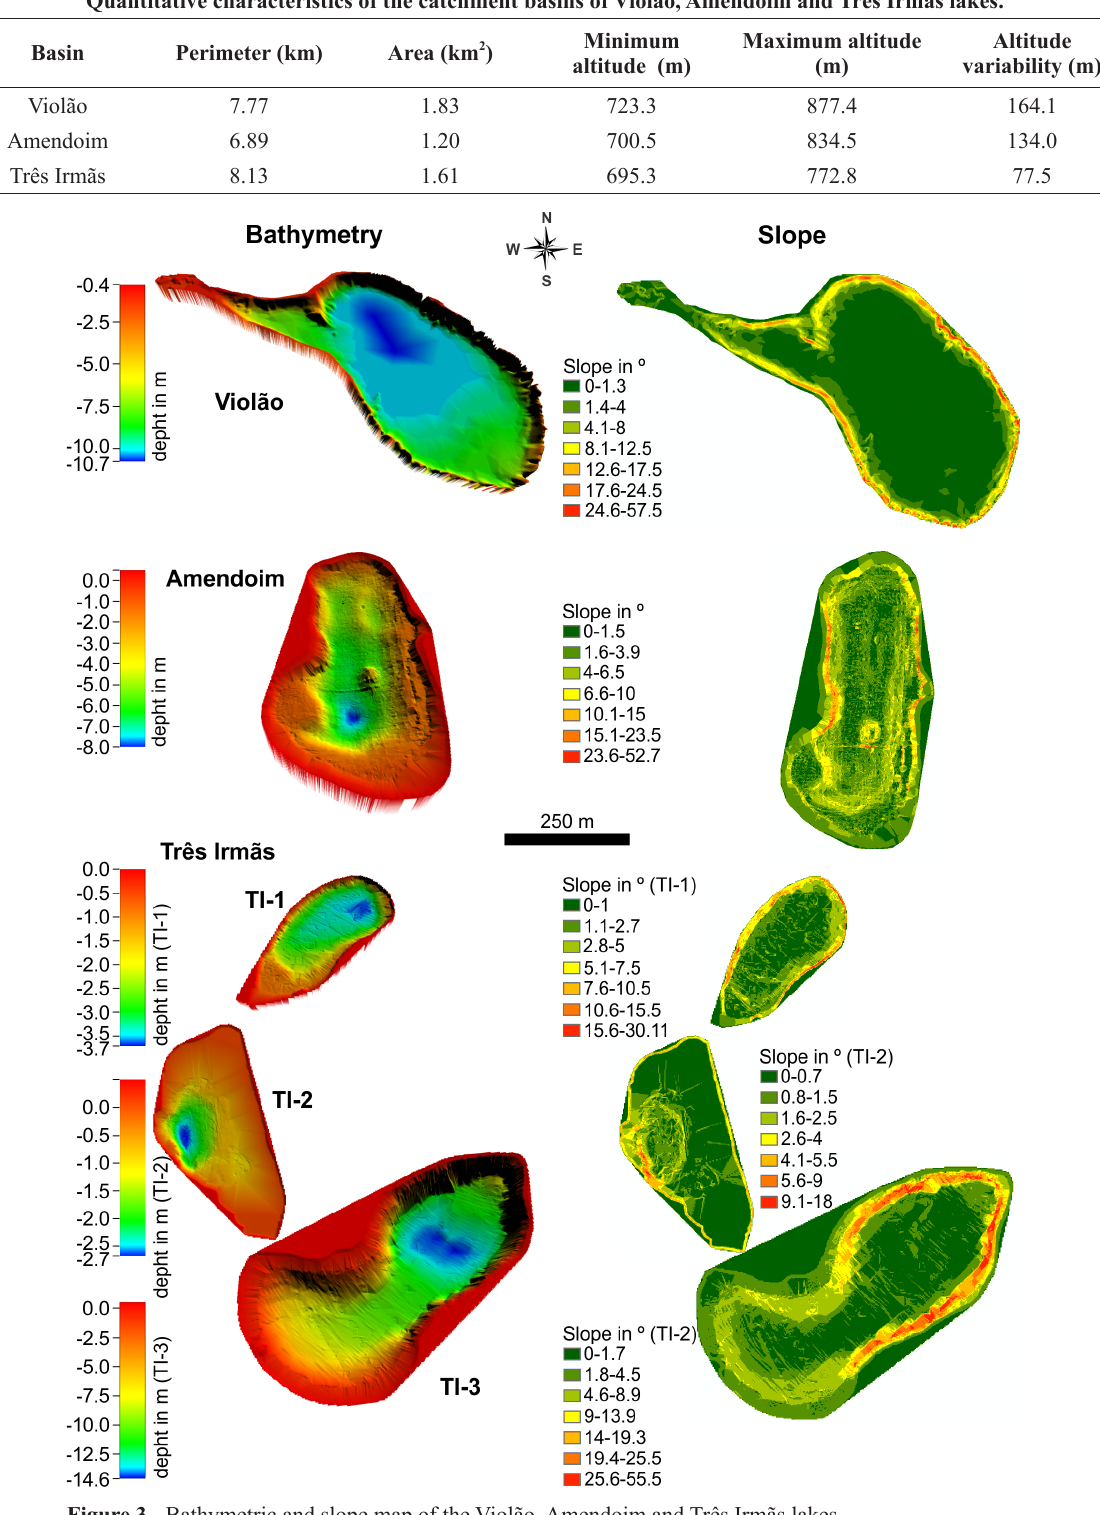
Figure 3 - Bathymetric and slope map of the Violão, Amendoim and Três Irmãs lakes.